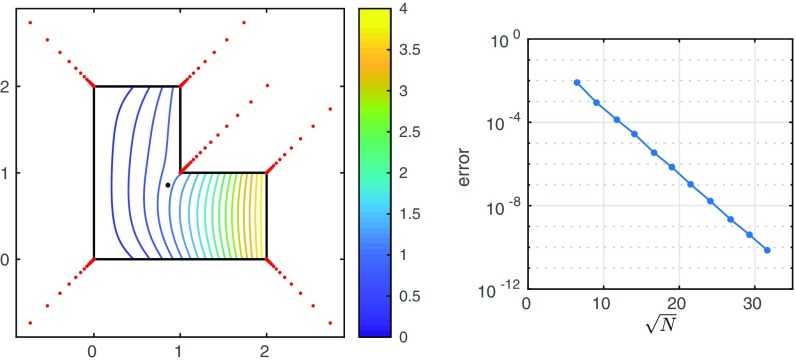
Laplace equation in an L-shaped domain. Poles are clustered exponentially near vertices and a least-squares problem is solved on the boundary to find coefficients for a global representation [1] of the solution accurate to 10 digits. The black dot in the interior marks the point z* of [1]. The curve of maximal error on the boundary shows root-exponential convergence.